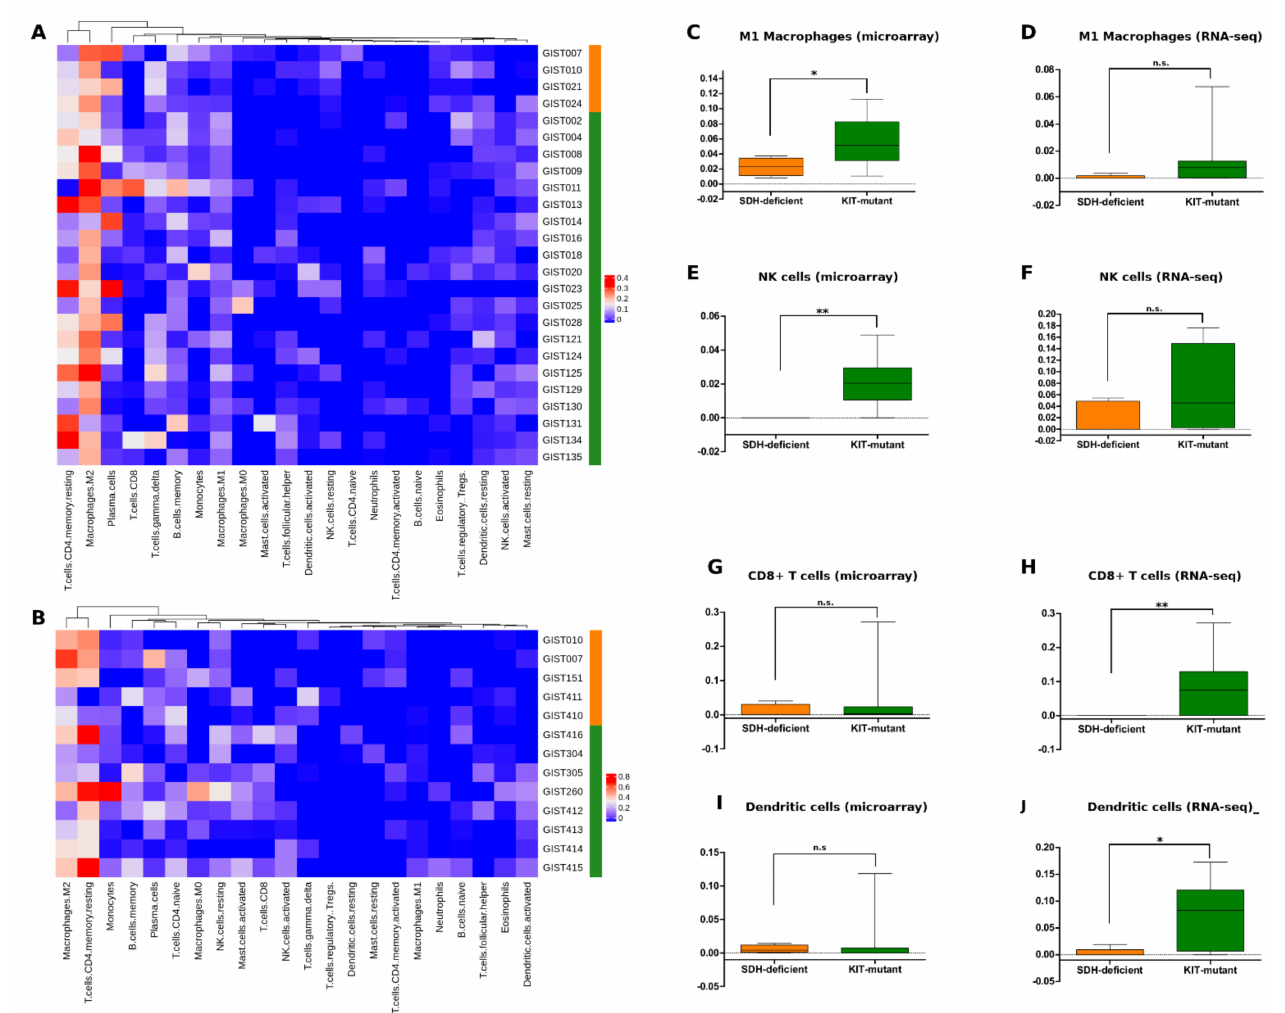
Figure 4. Tumor microenvironment analysis by CIBERSORT. Heatmaps represent the abundance of tumor-infiltrating cell subpopulations detected by microarray (( A ) number of SDH-deficient GISTs = 4; number of KIT-mutant GISTs = 21) and RNA-seq (( B ) number of SDH-deficient GISTs = 5; number of KIT-mutant GISTs = 8). Box plots ( C – J ) show the significant differences in the two GIST molecular subgroups of M1 macrophages, NK cells, CD8+ T-cells, and dendritic cells. Significance level is expressed as follow: ** p -value < 0.01; * 0.01 < p -value < 0.05; n.s., not significant. Orange labels correspond to SDH-deficient GISTs, while green labels correspond to KIT-mutant GISTs.